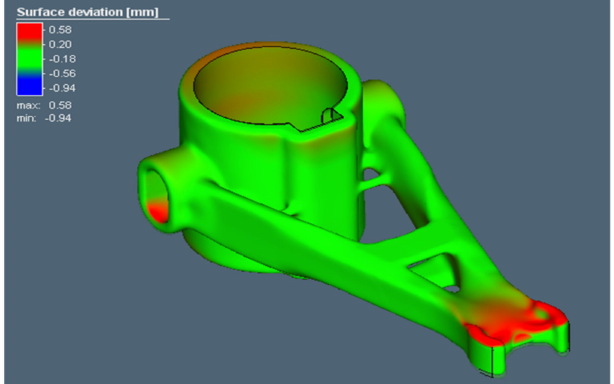
Figure 11. Stand-alone structural analysis using MSC Simufact.